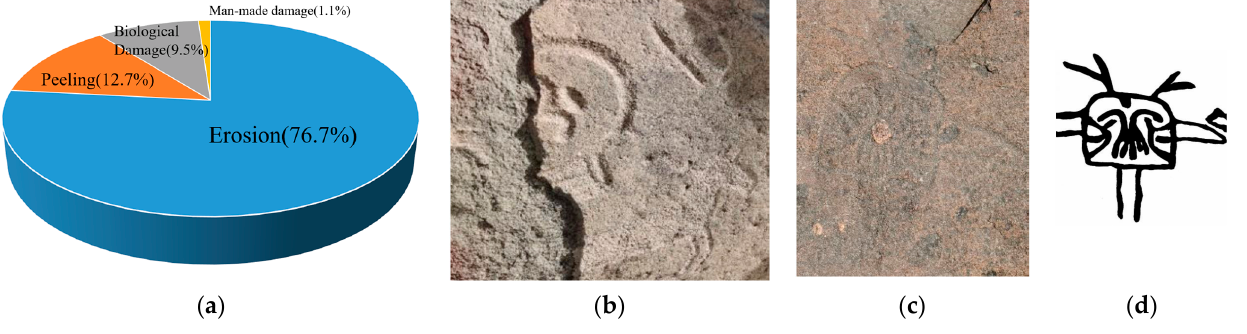
Figure 2. The main weathering types of the Helan Mountains petroglyphs [25]: ( a ) distribution of petroglyph weathering in Helankou; ( b ) peeling; ( c ) erosion; and ( d ) line drawing of petroglyph corresponding to ( c ).